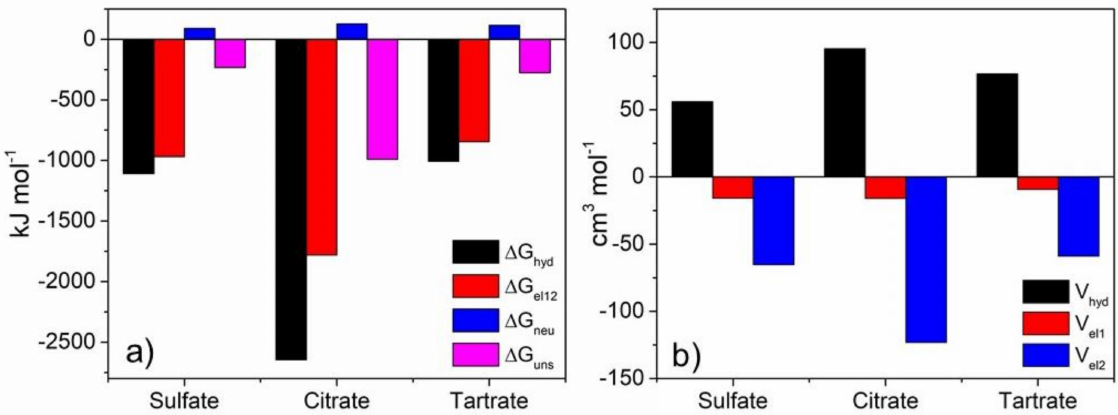
Figure 5. Thermodynamic parameters: ( a ) Gibbs free energies; ( b ) Volume contribution for salt